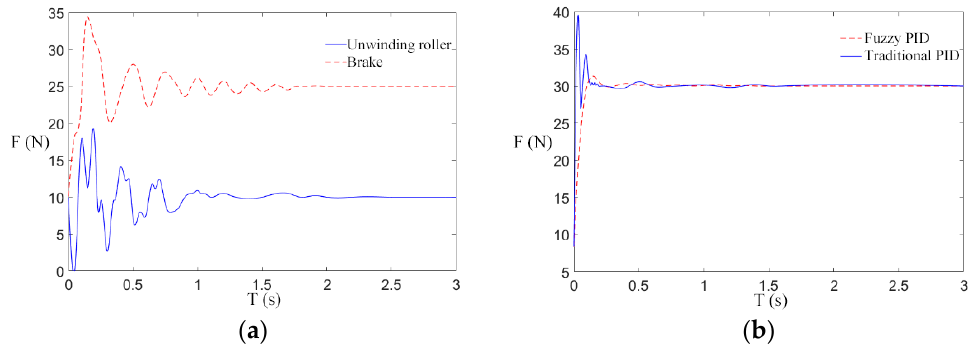
Figure 13. Tension response at 30 N reference tension. ( a ) Tension of unwinding roller and electro- magnetic brake; ( b ) Tension of take-up roll .